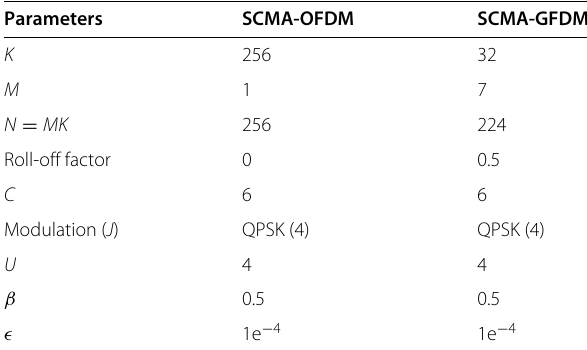
Table 2 Simulation